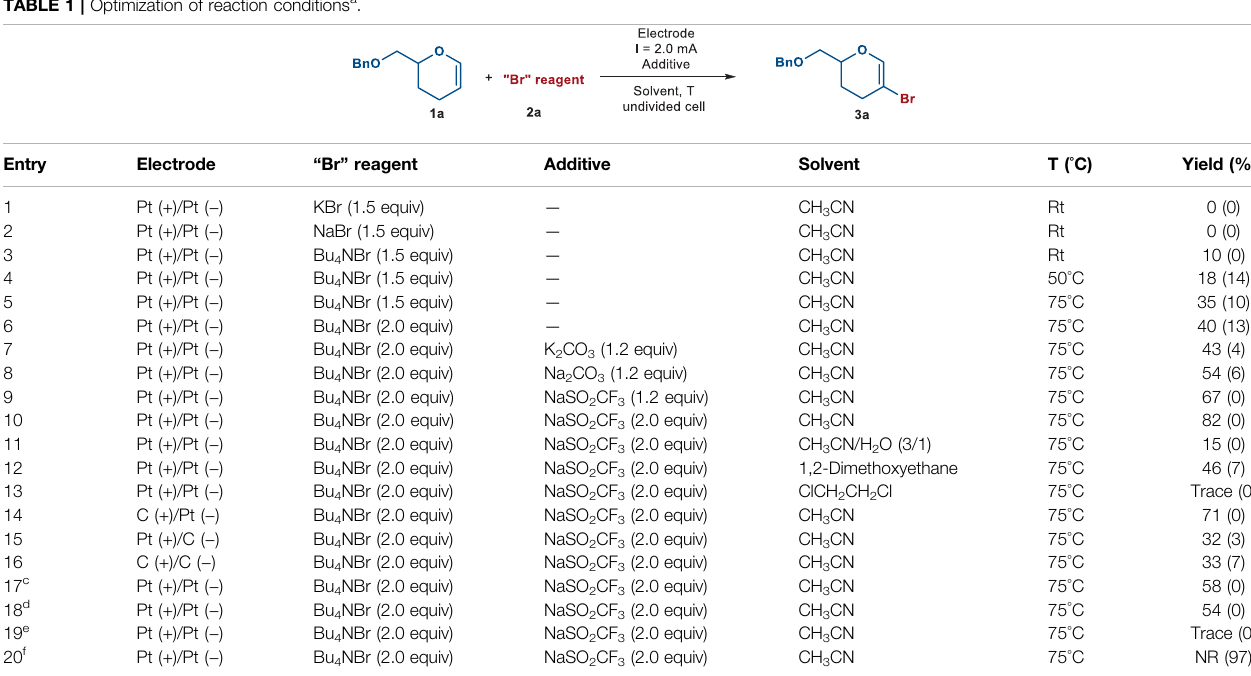
TABLE 1 | Optimization of reaction conditions a